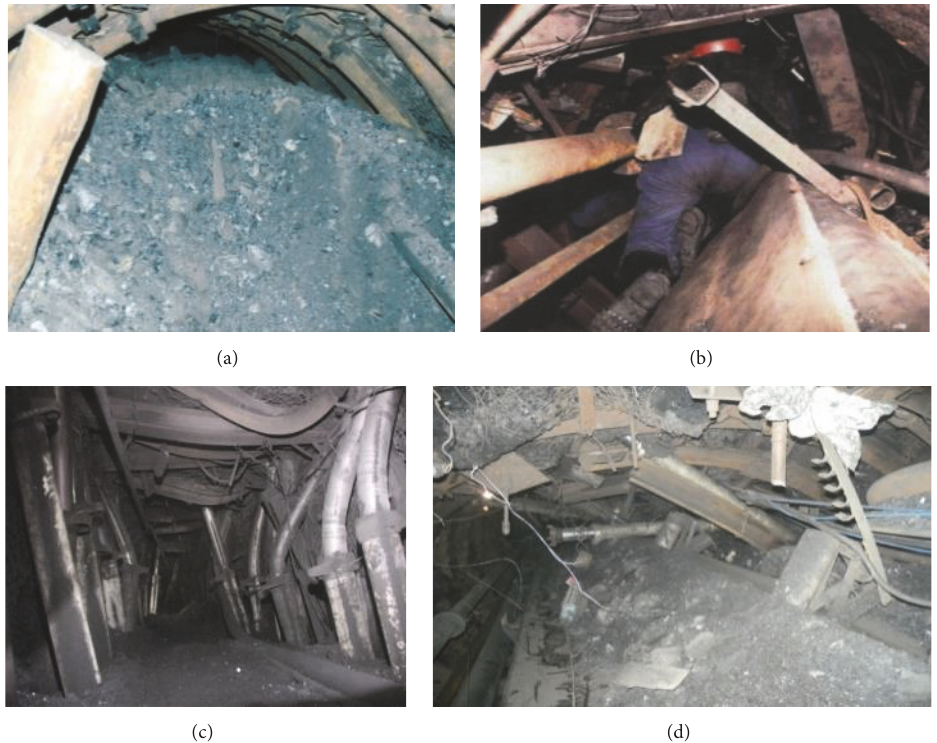
Figure 1: Major coal bursts that occurred in China. (a) Coal burst at Meiyukou Coal Mine. (b) Coal burst at Laohutai Coal Mine. (c) Coal burst at Huating Coal Mine. (d) Coal burst at Qianqiu Coal Mine, Yima City, Henan Province (June 5, 2008, 21201 longwall panel; 565 m of gateroad was damaged; 11 miners were injured and 13 were